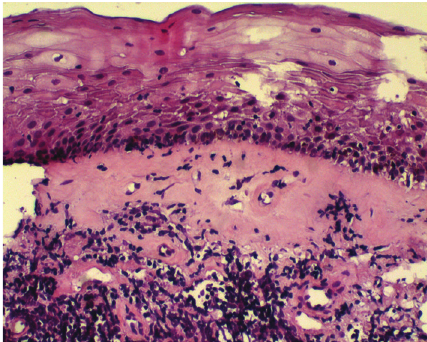
Figure 3: Epidermal thinning, dermic broad bundles of hyalinized